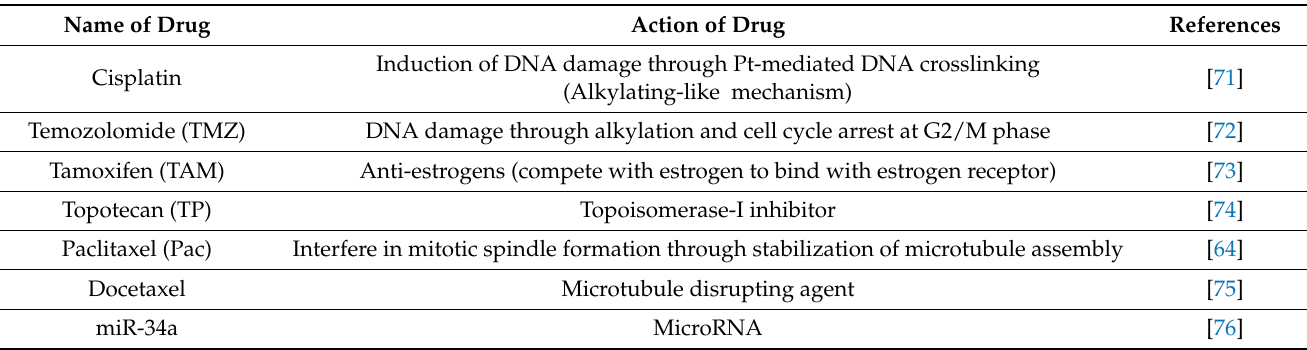
Table 2. Mechanistic action of some anti-cancer drugs in combination with the